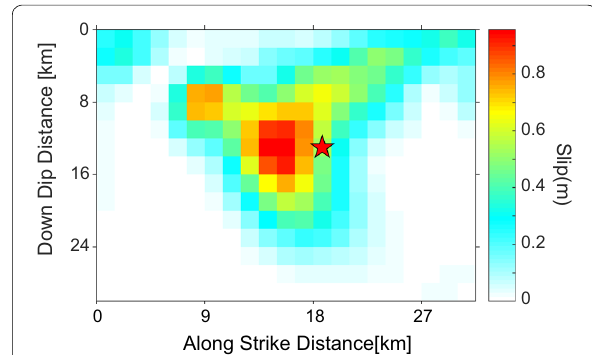
Fig. 2 Slip distribution based on joint inversions of InSAR data and teleseismic waveforms (Zhang et al. 2017). The hypocenter location is denoted by a red star. The slip amplitudes are shown in colors